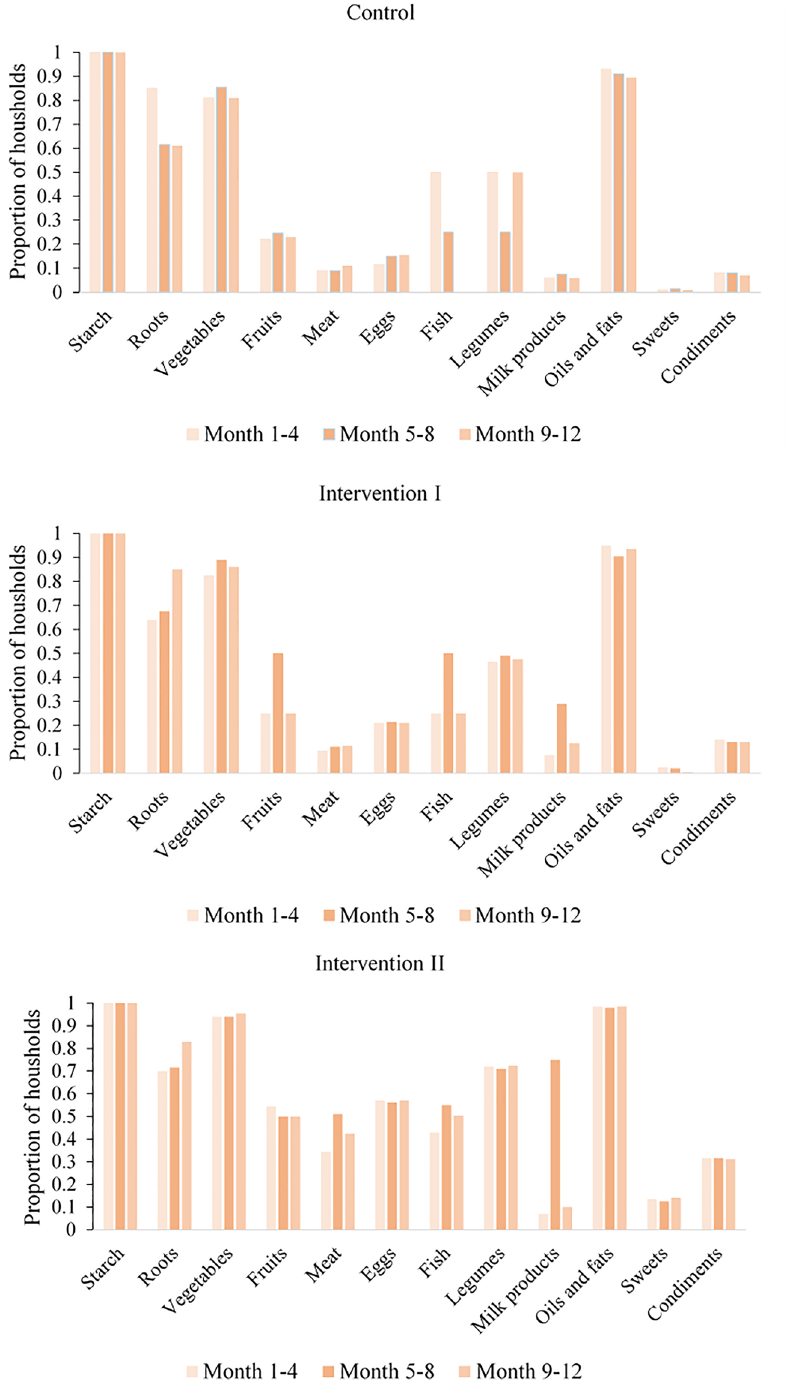
Figure 3. Proportion of households in each treatment group that consumed food items in four-monthly intervals over the 12-month study